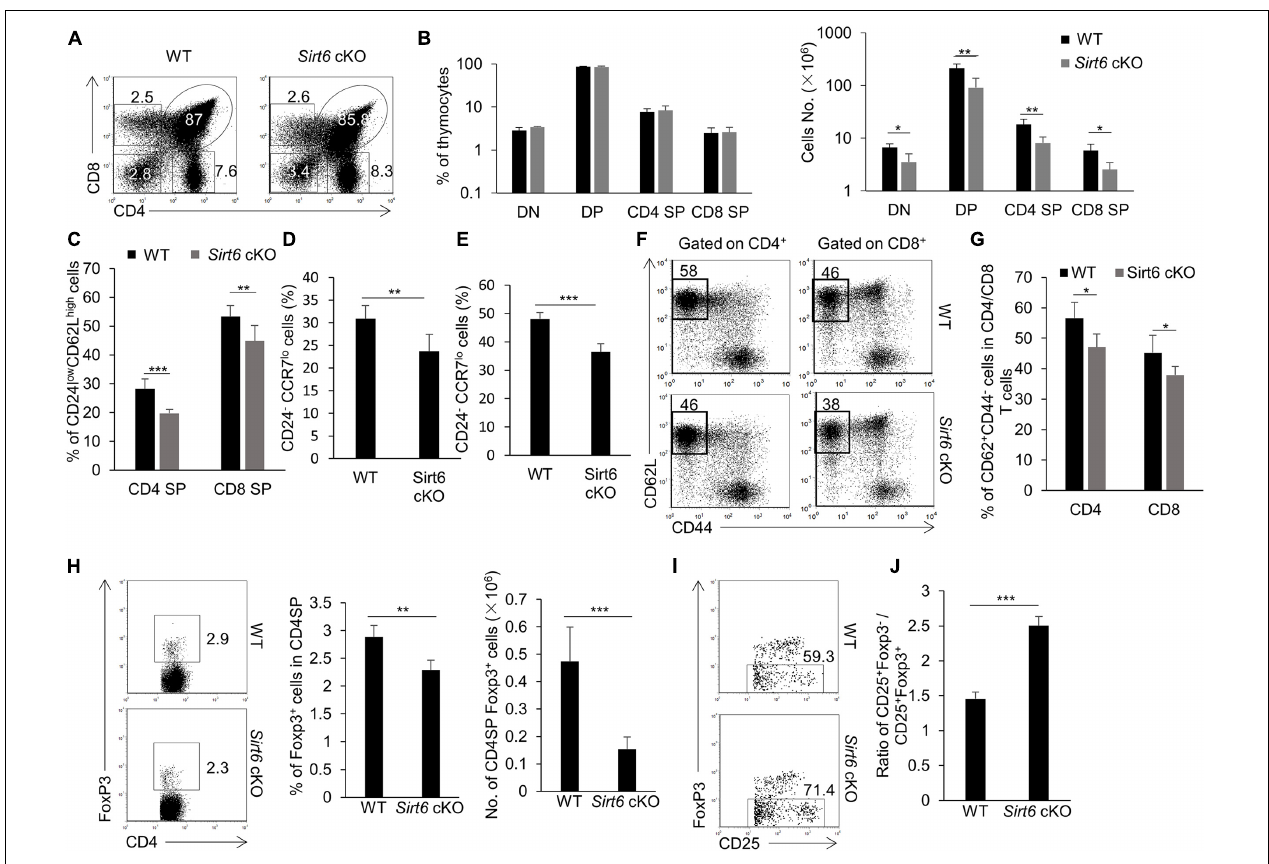
FIGURE 5 | The development of thymocytes is impaired after Sirt6 deletion in TECs. (A) Representative flow cytometry plots of CD4 and CD8 expressed on thymocytes derived from wild-type and Sirt6 cKO mice. (B) Frequencies (left) and absolute cell numbers (right) of DN (CD4 − CD8 − ), DP (CD4 + CD8 + ), CD4SP (CD4 + CD8 − ), and CD8 SP (CD4 − CD8 + ) thymocytes of Sirt6 cKO mice and littermate controls. (C) Frequencies of CD24 low CD62L high TCR β + CD4SP and CD24 low CD62L high TCR β + CD8SP mature thymocytes of wild-type and Sirt6 cKO mice. (D) Frequencies of CD24 − CCR7 lo CD4 + CD8 − TCR + CD5 + Foxp3 − thymocytes of wild-type and Sirt6 cKO mice. (E) Frequencies of CD24 − CCR7 lo CD4 − CD8 + TCR + CD5 + thymocytes of wild-type and Sirt6 cKO mice. (F,G) Representative flow cytometry plots (F) and frequency (G) of naïve (CD62L + CD44 − ) T cells in CD4 + or CD8 + splenocytes of wild-type and Sirt6 cKO mice. (H) Flow cytometry plots (left) and frequency (middle) and absolute cell numbers (right) of Foxp3 + nTreg of Sirt6 cKO mice and littermate controls. (I) Flow cytometry plots show the maturation of nTreg from precursors (CD4 + CD8 − CD25 + Foxp3 − ) to mature (CD4 + CD8 − CD25 + Foxp3 + ) in wild-type and Sirt6 cKO mice. (J) Ratio of precursor to mature nTreg between wild-type and Sirt6 cKO mice. N ≥ 4 per group. * p < 0.05, ** p < 0.01, and *** p < 0.001 (Student’s t